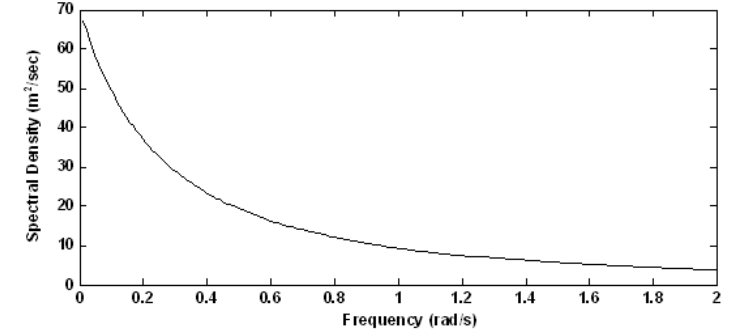
Figure 10. America Petroleum Institute (API) Wind Spectrum.